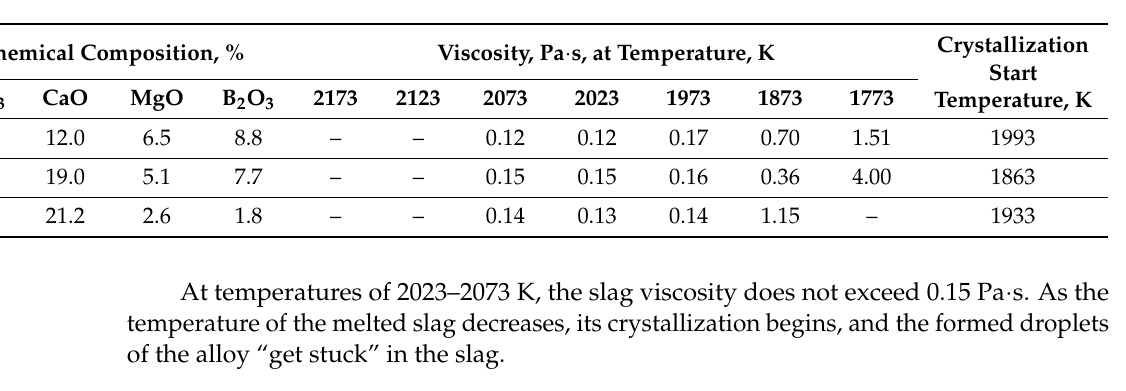
Table 1. Chemical composition and viscosity of boron-containing slags. Reprinted/adapted with permission from Ref. [14]. 1960, Kozakevitch,